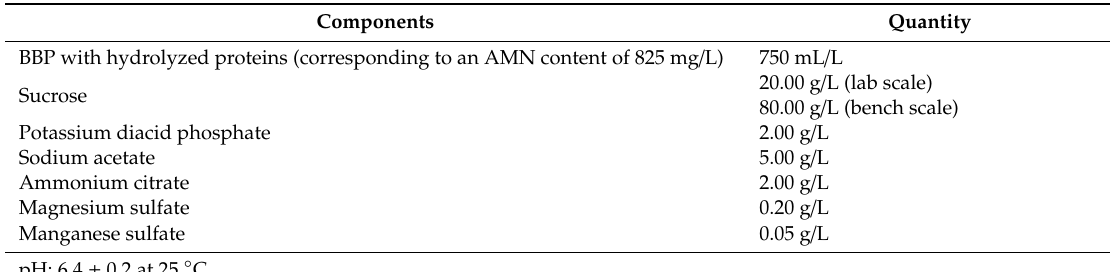
Table 1. Composition of the bovine blood plasma-based medium. Components